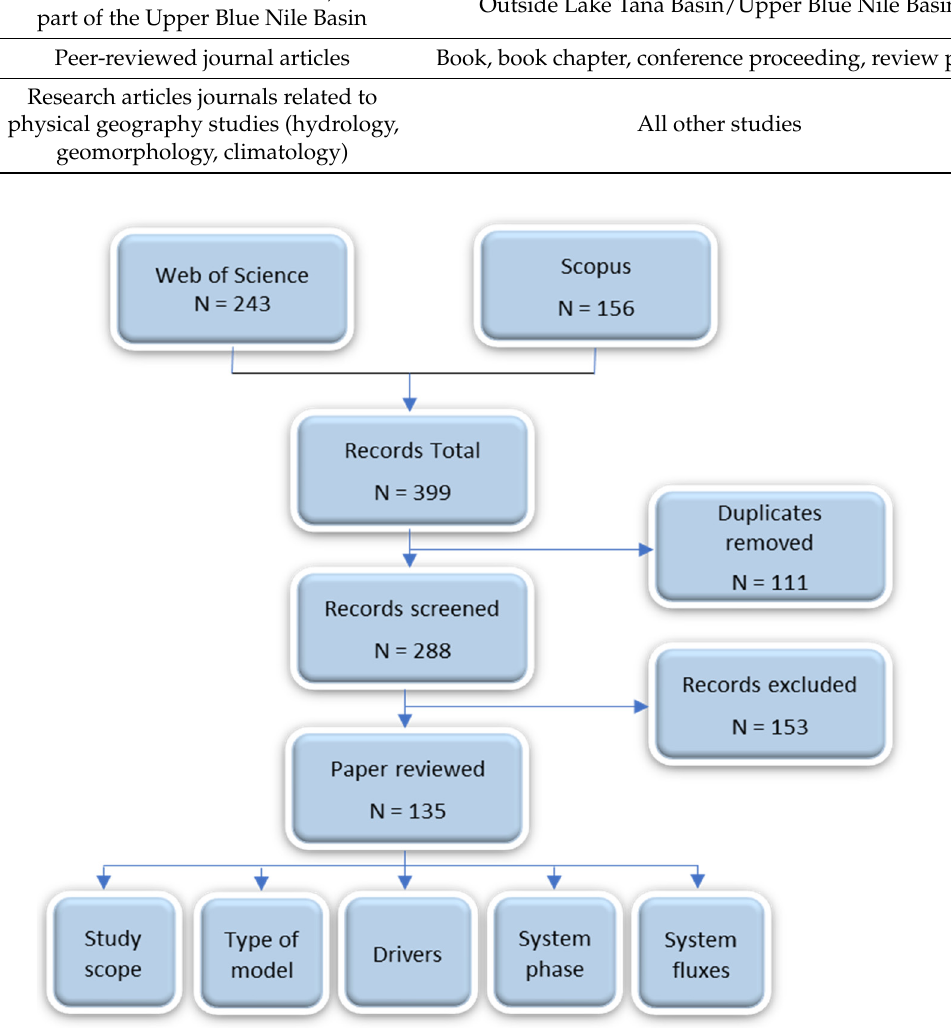
Figure 1. Flow diagram of the process of systematic review.